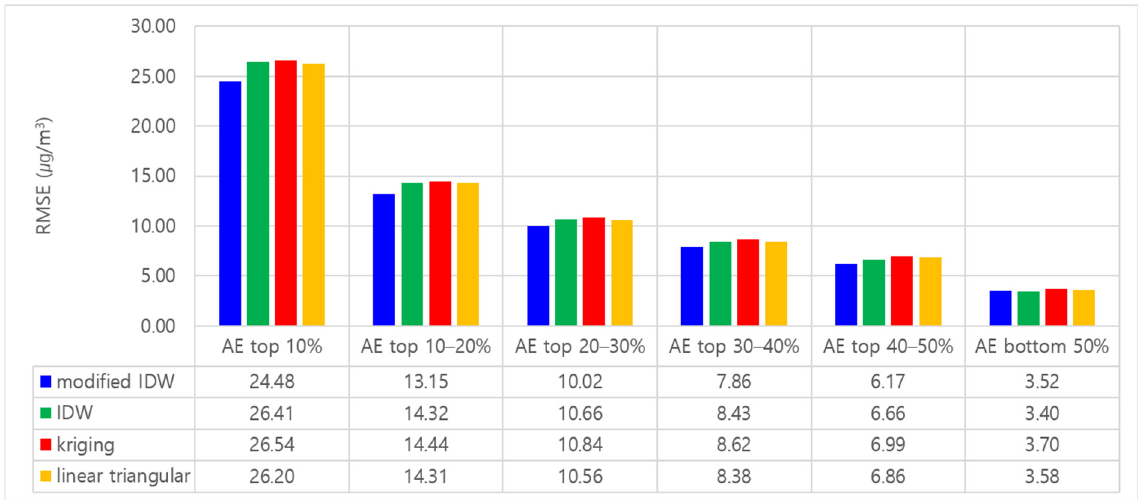
Figure 6. MAPE of estimated PM10 for different algorithms based on the AE levels.